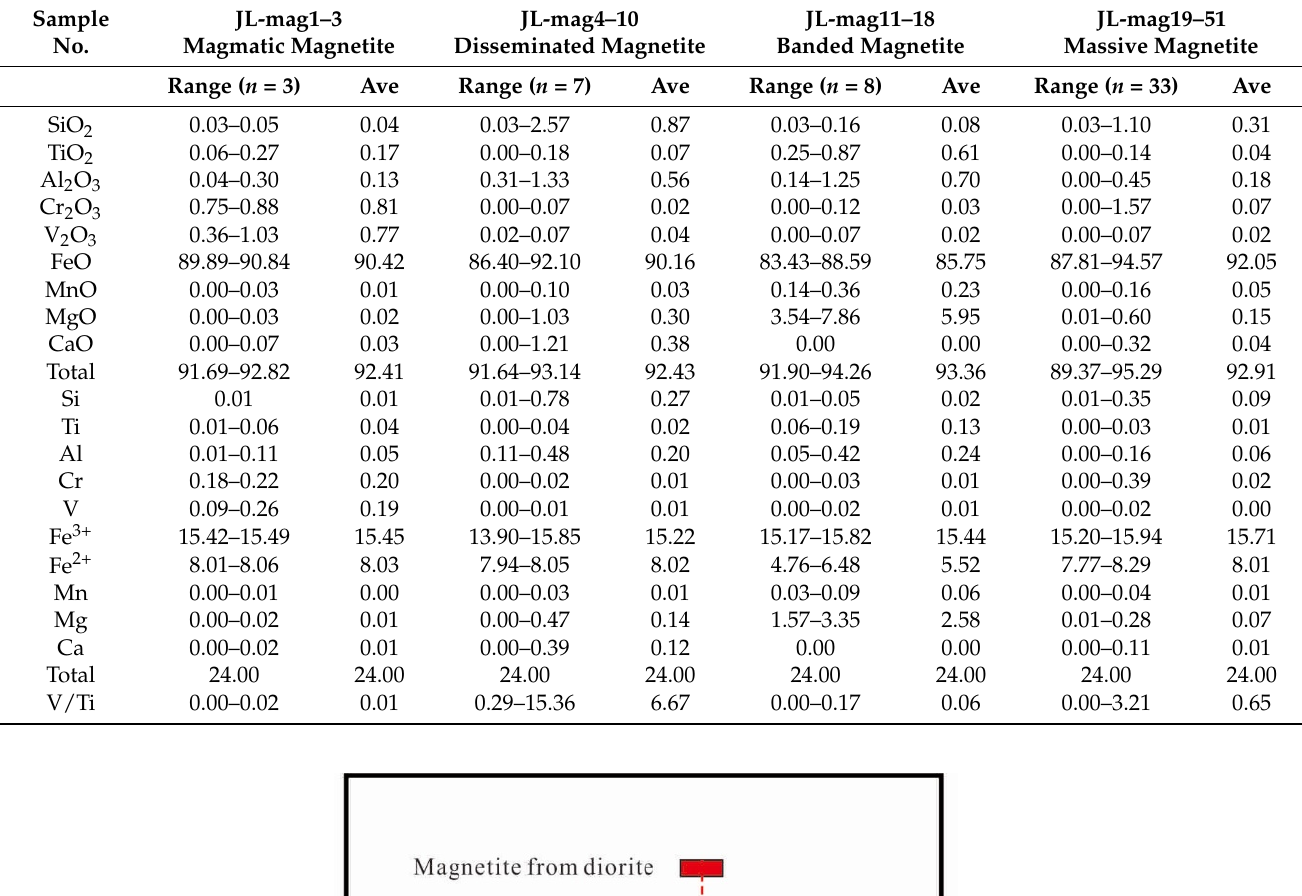
Table 5. EPMA data for magnetites from Jinling diorites, skarn, and ore.